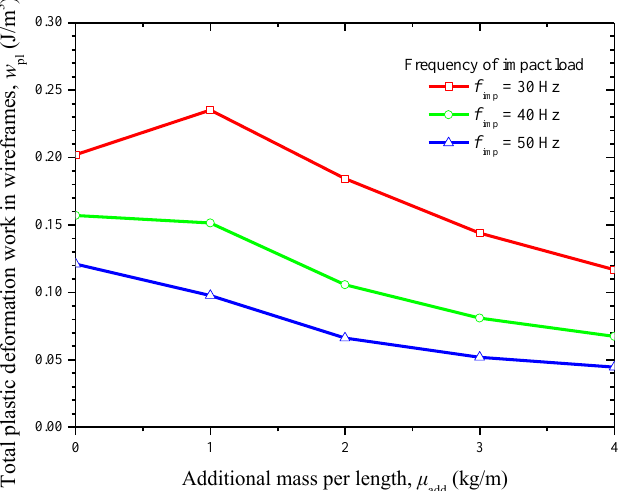
Figure 14. Total plastic deformation work in the wireframes versus the mass addition around the flywheel perimeter for several impact frequencies.